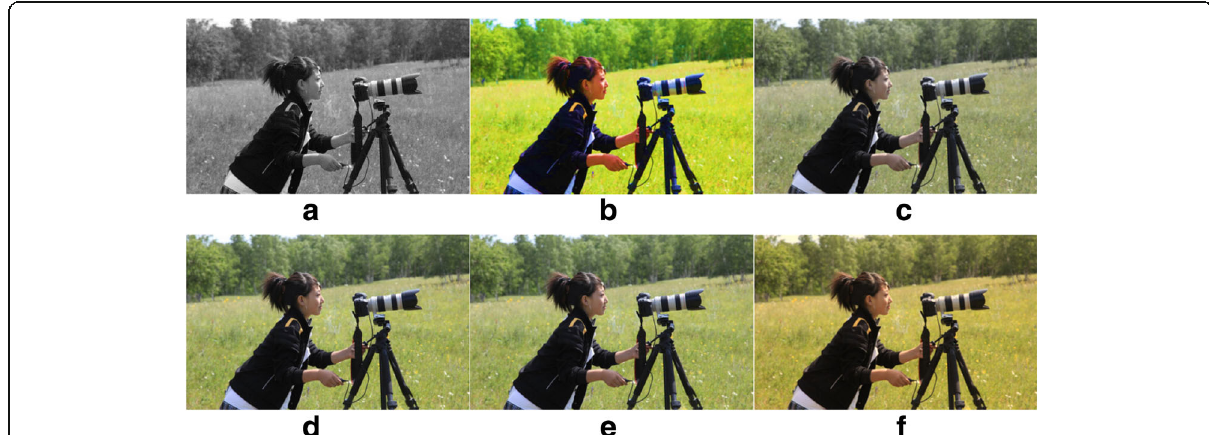
Fig. 10 The 512×512 Cameraman image with non-realistic art processing measurement rate of 0.2, Image contrast reconstructed by each algorithm.